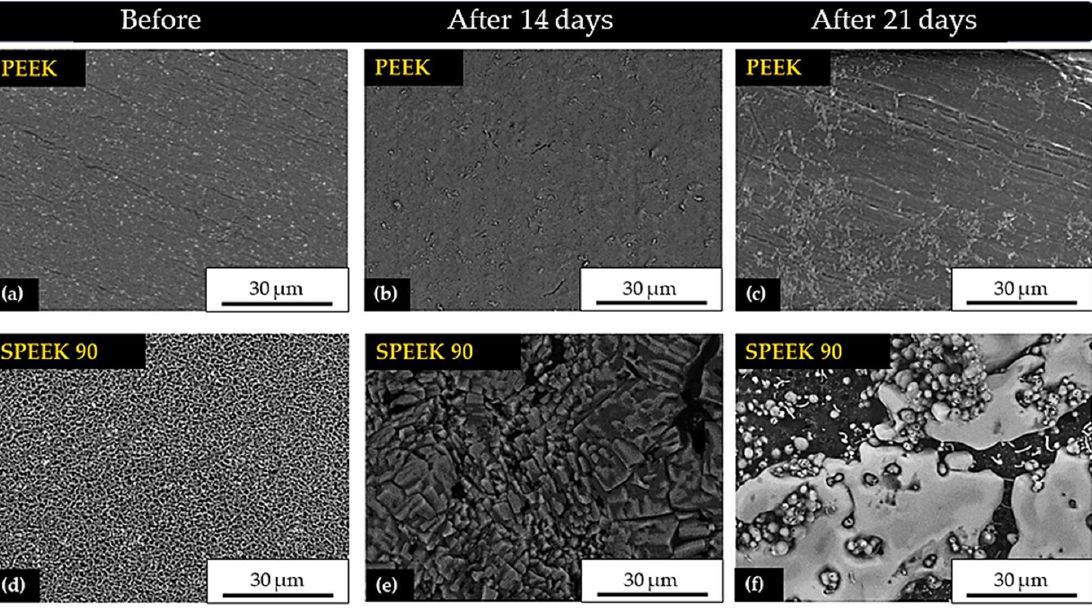
Figure 12. SEM micrographs of PEEK and SPEEK 90 surfaces, (a and d) and after immersion in SBF for 14 (b and e) and 21 days (c and f), with 3000× magnification. ( b , e ) and 21 days ( c , f ), with 3000 ×